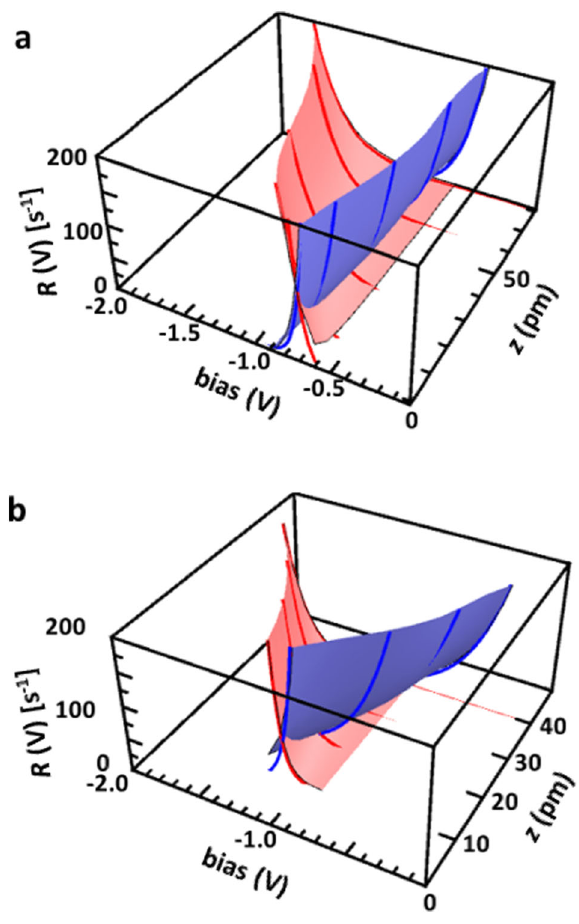
Fig. 5 Full characterisation of electron tunnelling for two different dots. a , b 3D graphs of the recharge (blue)/discharge (red) rates as a function of both the bias, V , and the tip-height, z , for two different SaQDs. a Corresponds to the data in Fig. 4, for the data in ( b ), see Supplementary Fig.